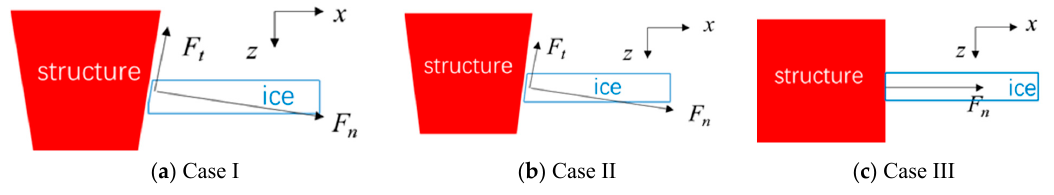
4 of 21 Figure 2. Loop of ice crushing force calculation. 2.2. Discretization The 2D geometric models of ice sheets and structures are made in the horizontal plane. The structure at the waterline is discretized with polygonal nodes while the ice edge is composed of scattered nodes on a polyline. A geometric tool is used to detect the overlapped area between the structure polygon and ice polyline. Then, the horizontal contact area can be calculated, as shown in Figure 3. Figure 3. Geometrical discretization of ice – structure interaction. 2.3. Local Ice Force and Contact Area There are three typical cases for a structure’s interaction with level ice. The first case is the initial ice contact with a highly-inclined structure (Case I). Here, only part of front edge of the ice sheet crushes against the structure. The contact area looks like a triangle, which tends to increase as the